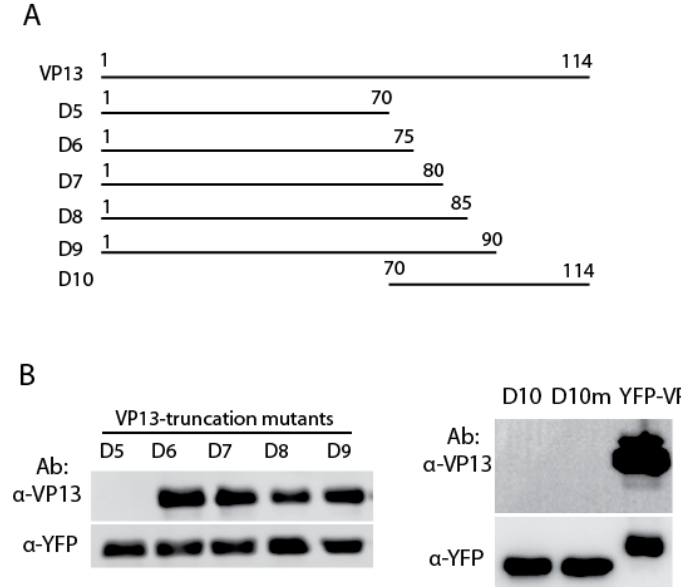
Figure 3. Epitope locates in residues aa66-75 of VP13. ( A ) Illustration of VP13 and truncation mutants. D5 to D10 indicate VP13 deletion constructs. The numbers above lines indicate positions of amino acids in VP13; ( B ) Detection of truncation mutants D6 to D9 but not D5 and D10. HEK293 cells were transfected with the VP13 truncation constructs and harvested for immunoblotting with VP13 Mab at 1:5000. D10: aa71S (type 1); D10m: aa71L (type 2). Ab: antibody